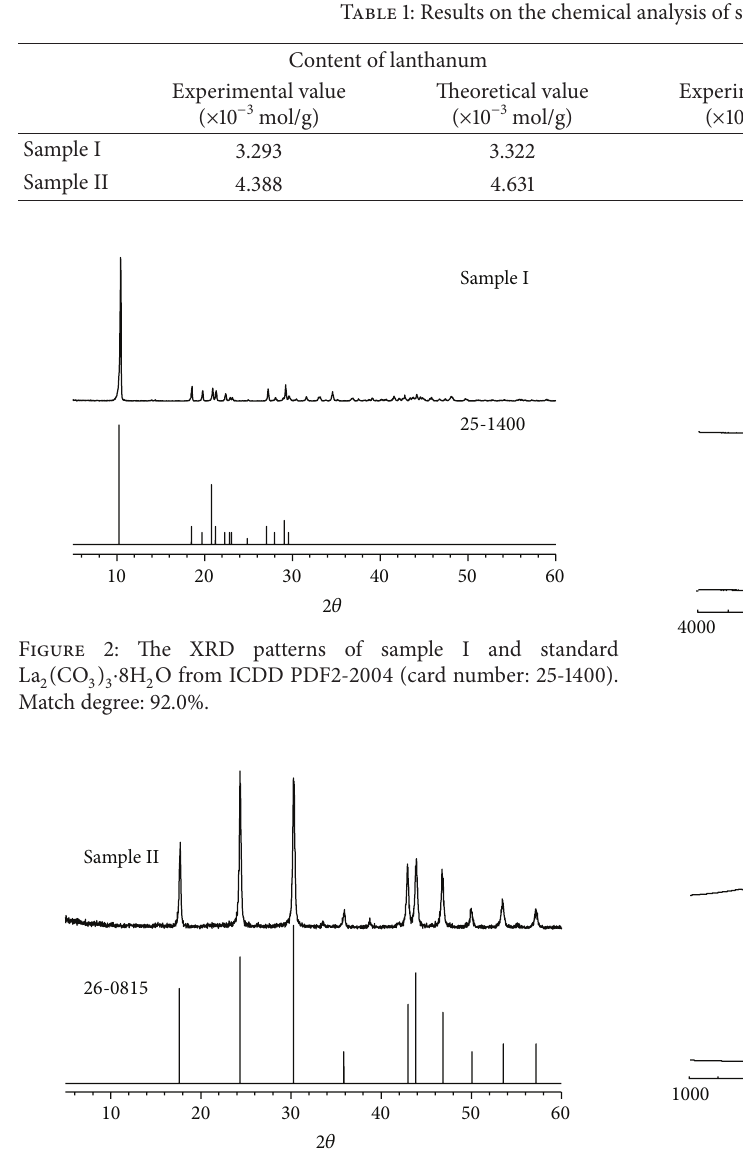
Figure 3: The XRD patterns of sample II and standard La(OH)CO 3 from ICDD PDF2-2004 (card number: 26-0815). Match degree: 95.7%.